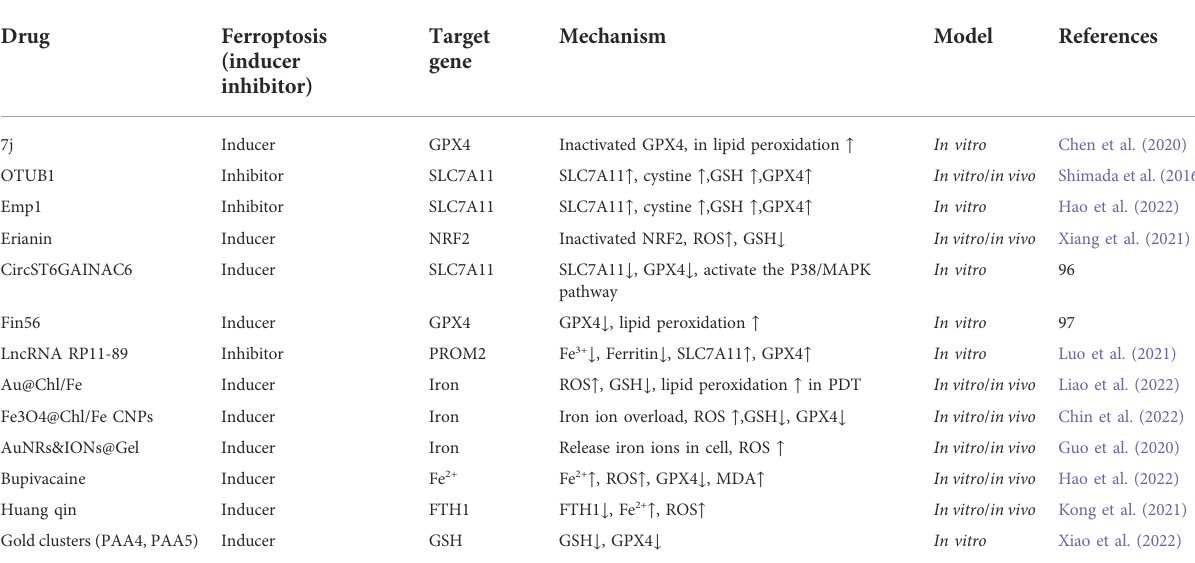
TABLE 1 Treatments for induction of ferroptosis in bladder